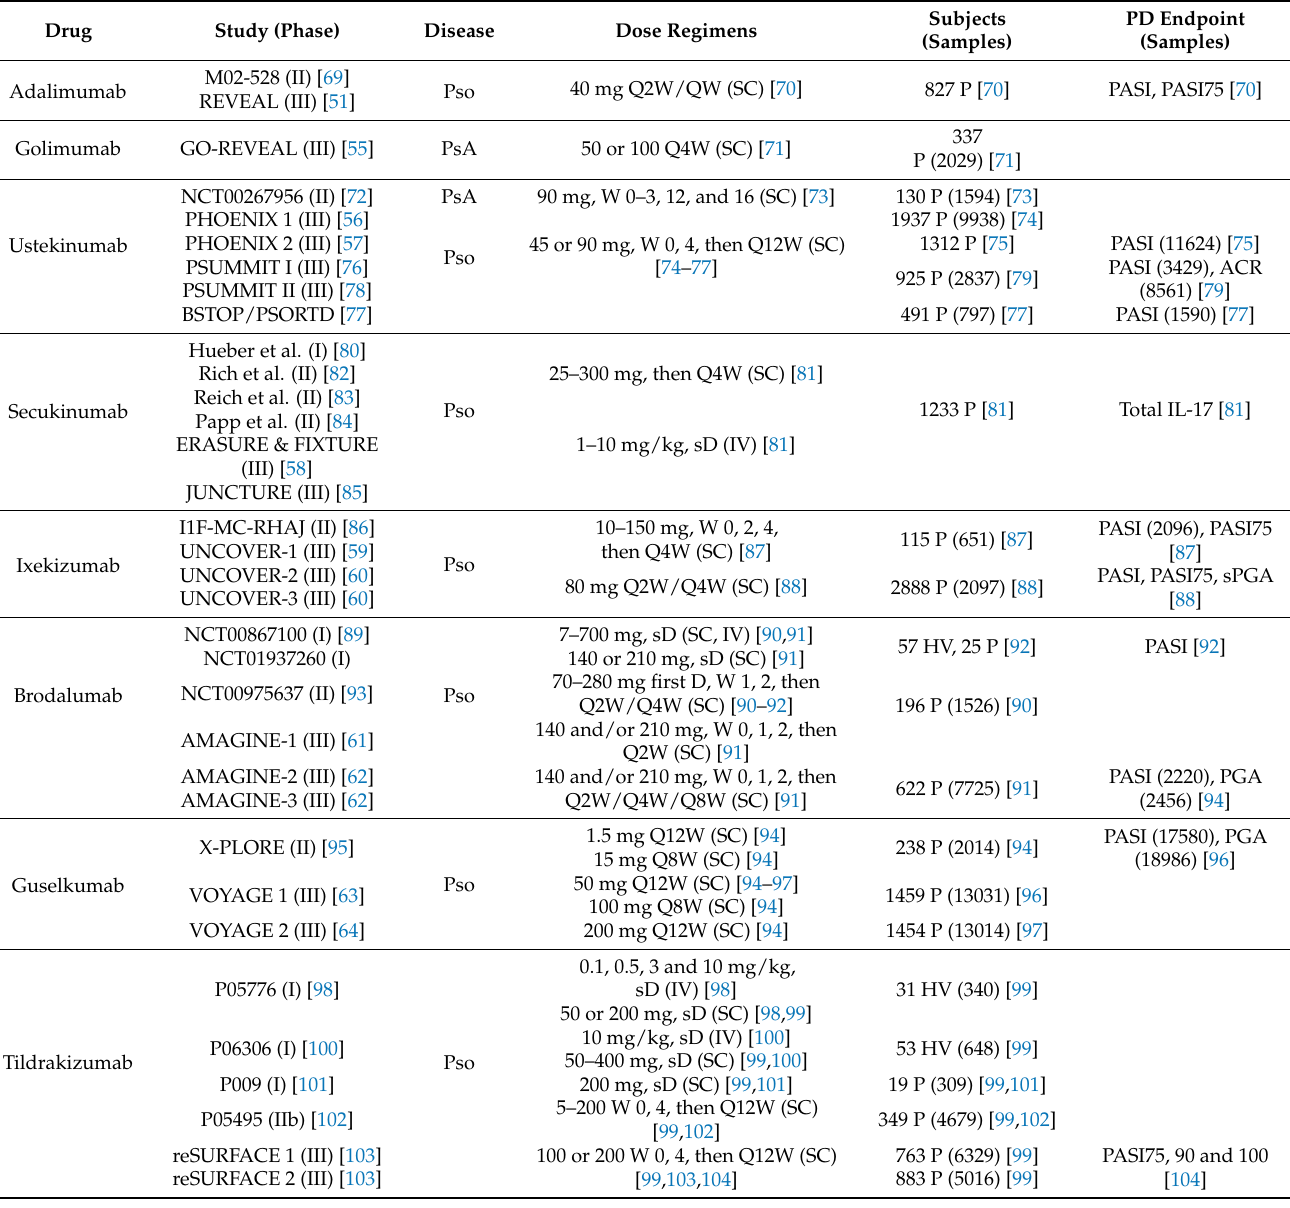
Table 2. Published pharmacokinetics clinical trials of monoclonal antibodies indicated for